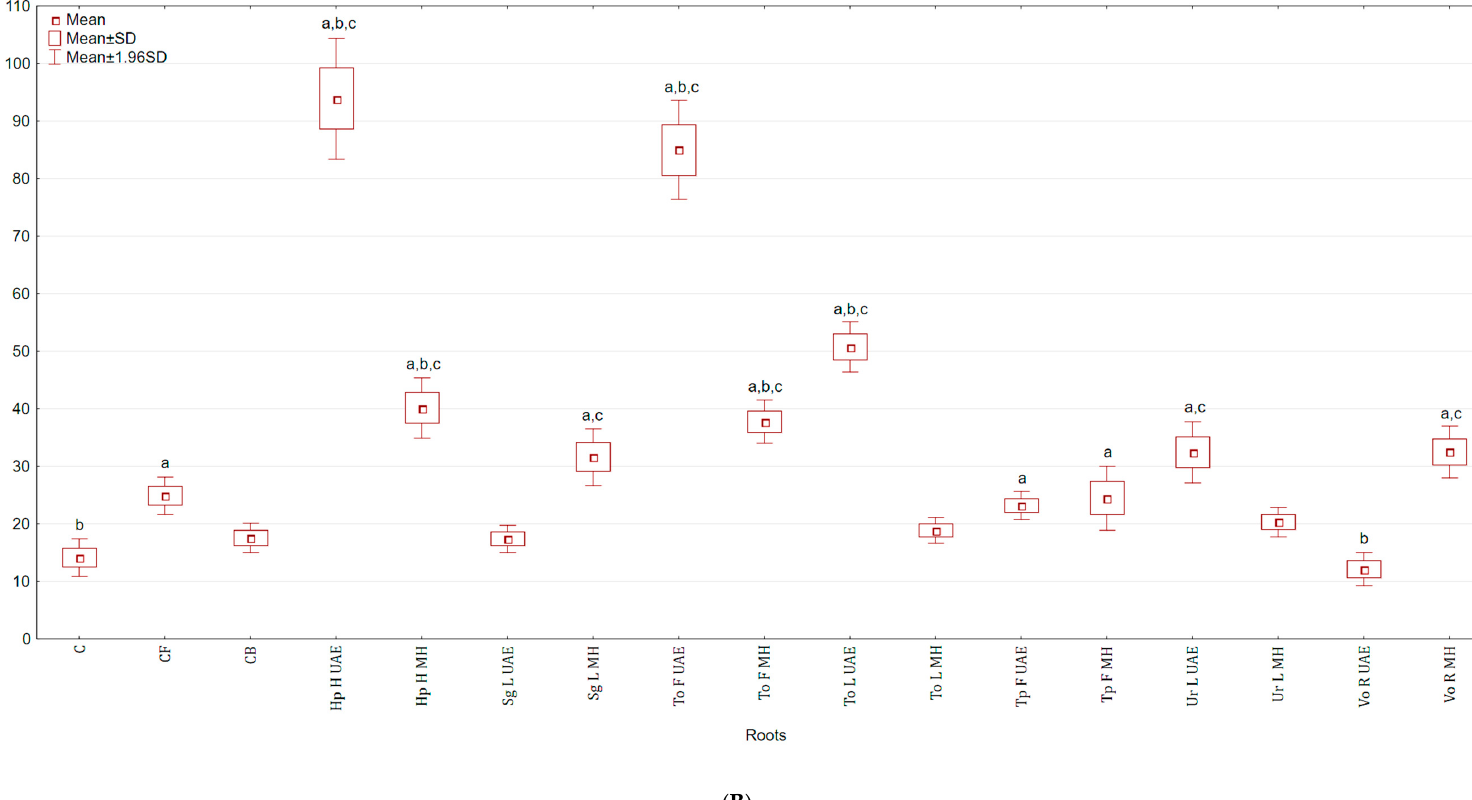
Figure 4. ( A ) Effect of the foliar application of botanical extracts on the total phenolic compounds of celeriac leaves (N = 4). ( B ) Effect of the foliar application of botanical extracts on the total phenolic compounds of celeriac roots (N = 4). (a) Statistically significant differences ( p < 0.05) between the control group (C) and extracts. (b) Statistically significant differences ( p < 0.05) between water formulation (CF) and extracts. (c) Statistically significant differences ( p < 0.05) between commercial biostimulant (CB) and extracts. 1st term of leaves rosette collection—samples taken for analyses 7 days after the second spraying. 2nd term of leaves rosette collection—samples taken for analyses after harvesting. Abbreviations: UAE, ultrasound assisted extraction; MH, mechanical homogenisation; Hp H, Hypericum perforatum L. (St. John’s wort, herb); Sg L, Solidago gigantea Ait. (giant goldenrod, leaf); To F, To L, Taraxacum officinale (L.) Weber ex F.H. Wigg (common dandelion, flower, leaf); Tp F, Trifolium pratense L. (red clover, flower); Ur L, Urtica dioica L. (nettle, leaf); Vo R, Valeriana officinalis L. (valerian, root).